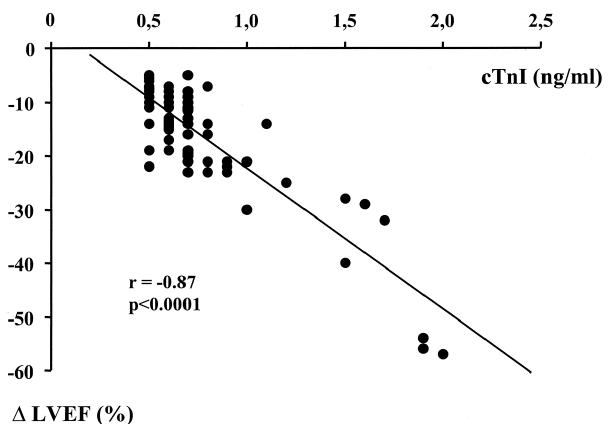
Figure 4. Linear correlation between TnI peak detected during chemotherapy and subsequent % EF drop [33].